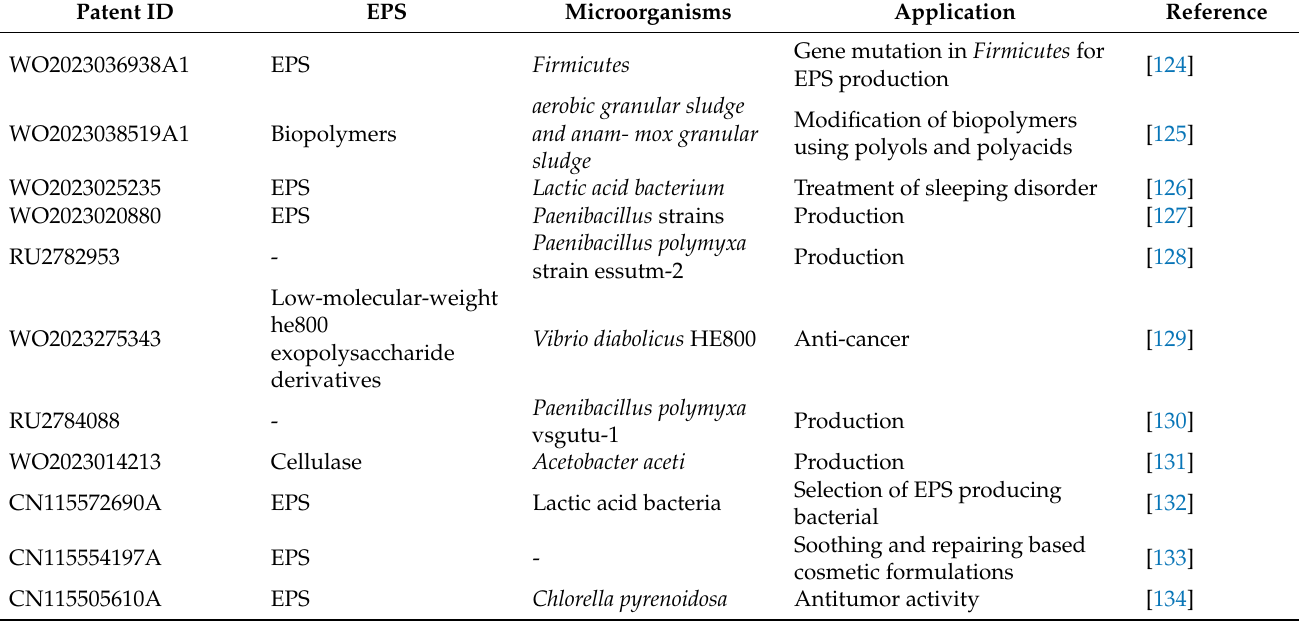
Table 3. Patents awarded in microbial exopolysaccharide-related